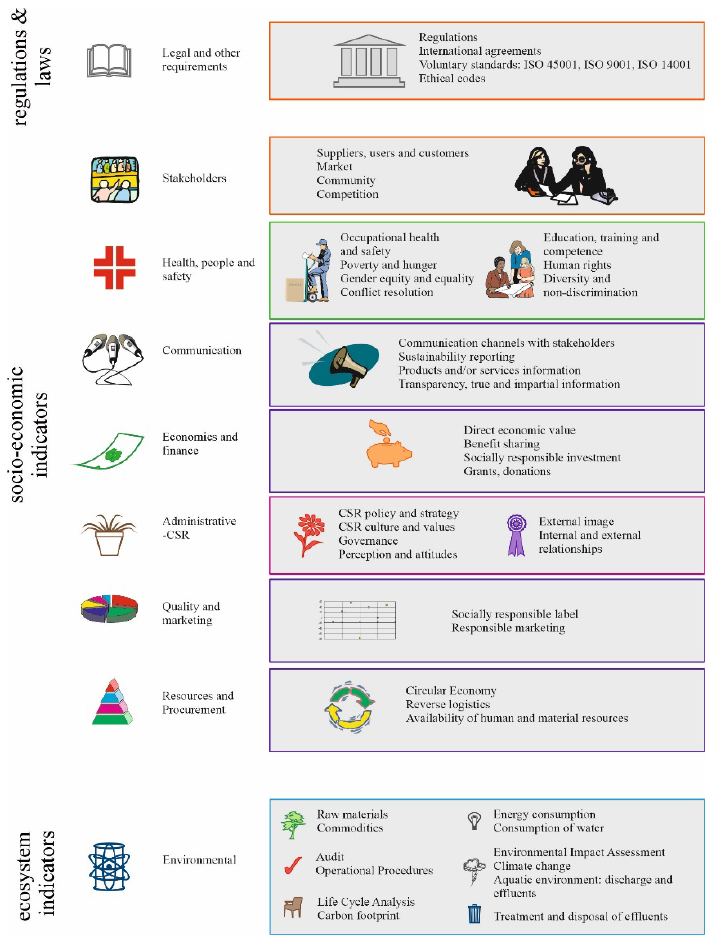
Figure 4. Main indicators of the SDGs used by experts. Note. Own elaboration.